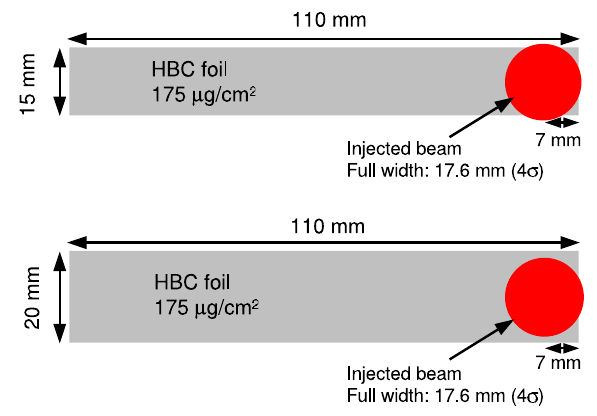
FIG. 12. The second generation primary stripper foils having smaller vertical sizes of 15 mm (upper) and 20 mm (lower) plotted together with injected beam positioning for the RCS operation in run 36. The foil edge from the injected beam center kept the usual setting of 7 mm in the horizontal direction with no offset of the foil in the vertical direction.